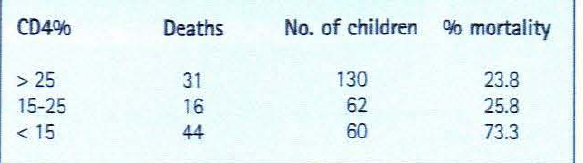
TABLE 11. CORRELATION OF CD4 CELLOfo Wffil MORTAUTY